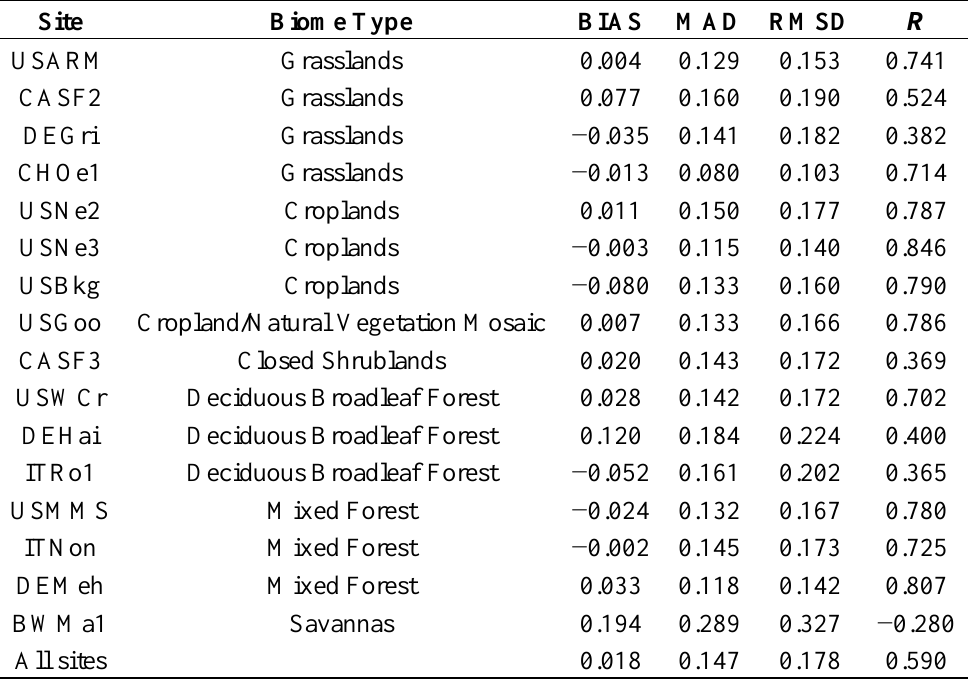
Table 3. Statistical results for the comparisons between estimated and observed EF for each FLUXNET